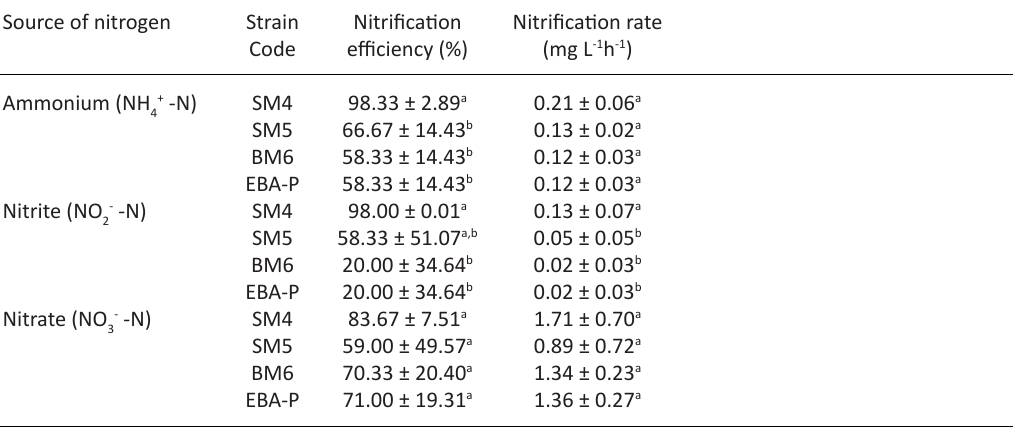
Table 3. Heterotrophic nitrification capacity of selected strains with ammonium (NH nitrate (NO 3- -N) as the sole source of nitrogen under aerobic conditions Source of